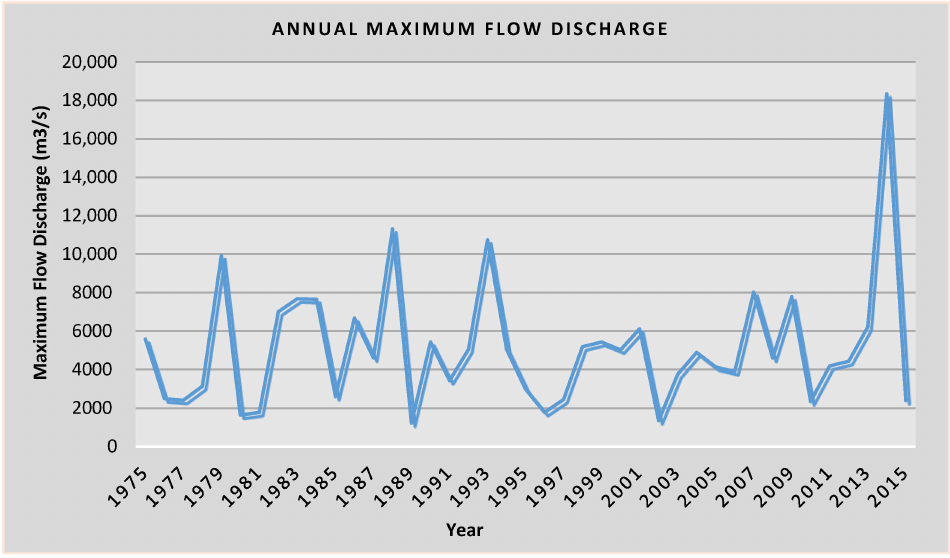
Figure 2. Maximum annual flow discharge of Sg. Kelantan from 1975 to 2015.